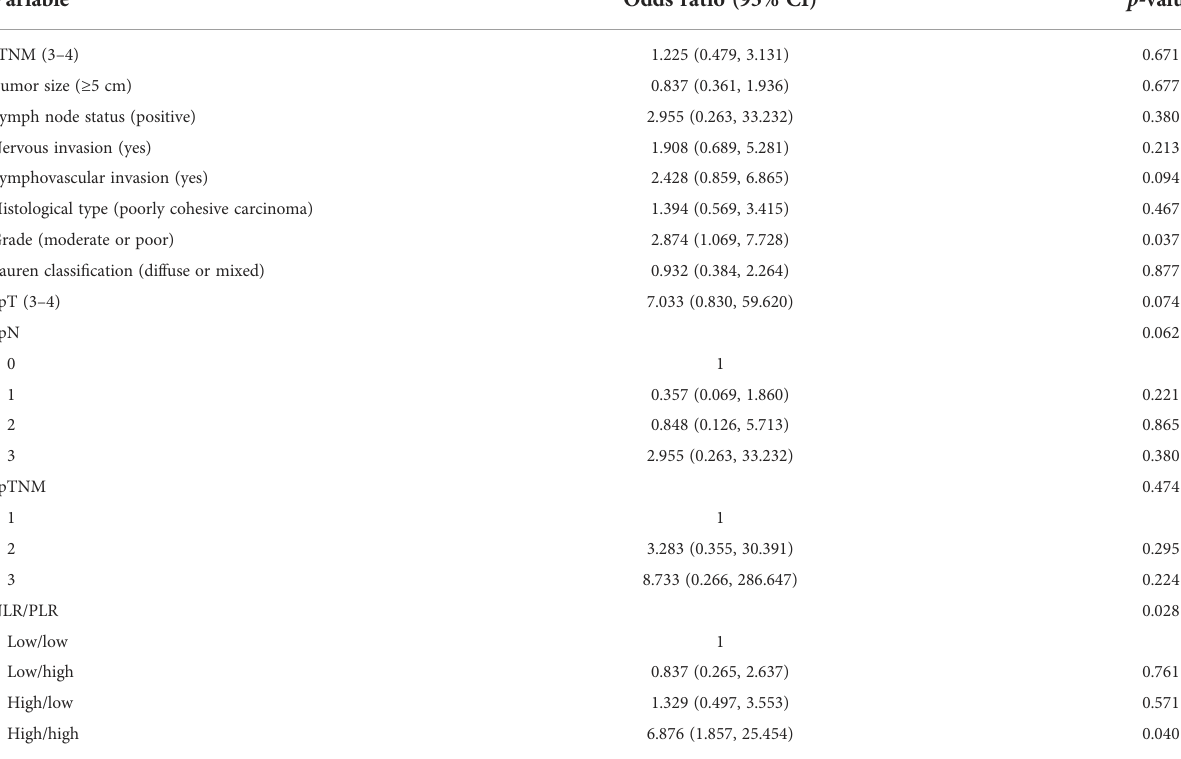
TABLE 4 Multivariate analysis of